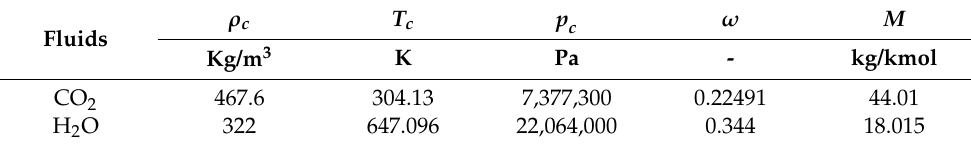
Table A1. Constants for CO 2 and H 2